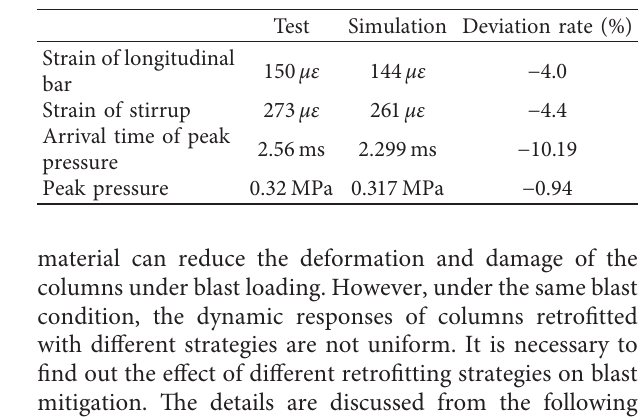
Figure 8: Deformation of tested column. (a) Test result. (b) Numerical result. Table 3: Comparison of numerical results and test